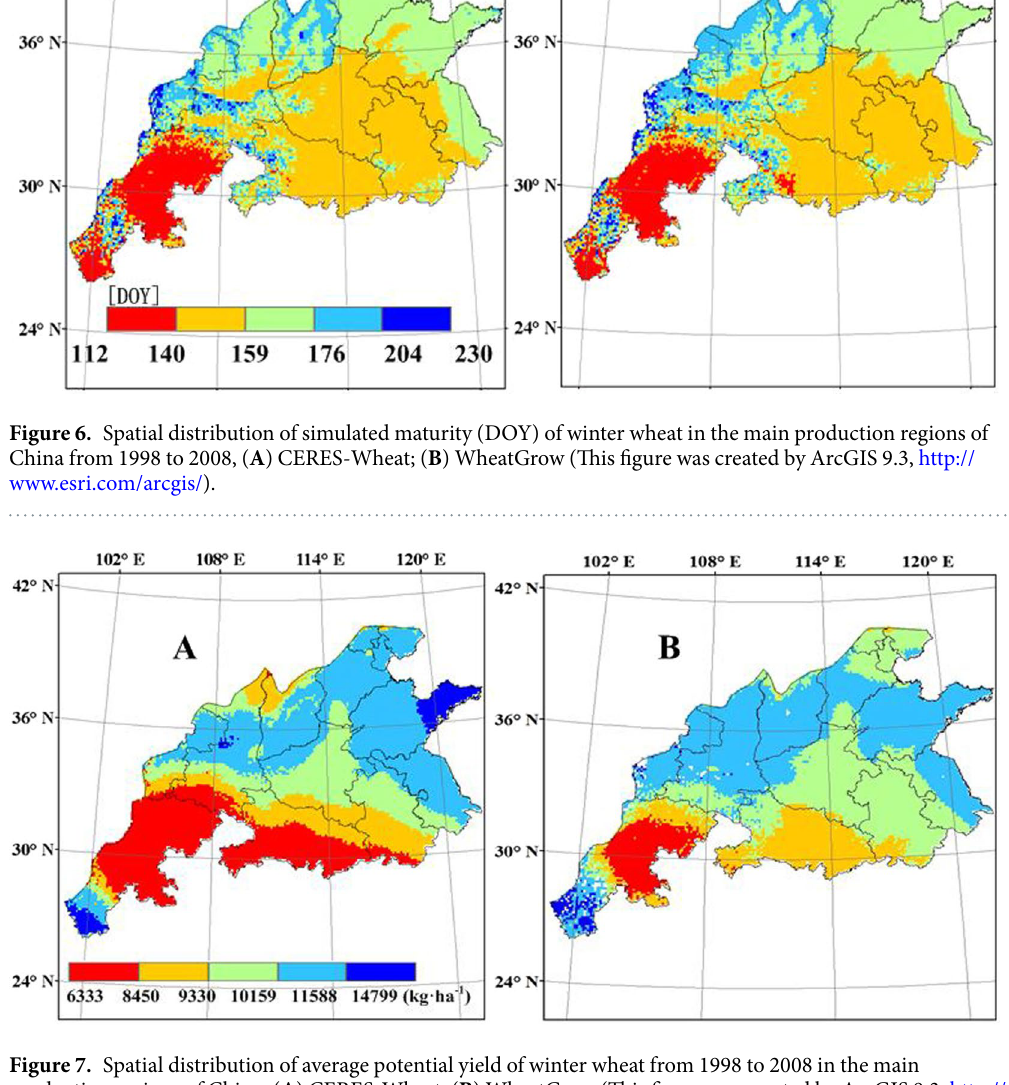
Figure 7. Spatial distribution of average potential yield of winter wheat from 1998 to 2008 in the main production regions of China, ( A ) CERES-Wheat; ( B ) WheatGrow (This figure was created by ArcGIS 9.3, http://